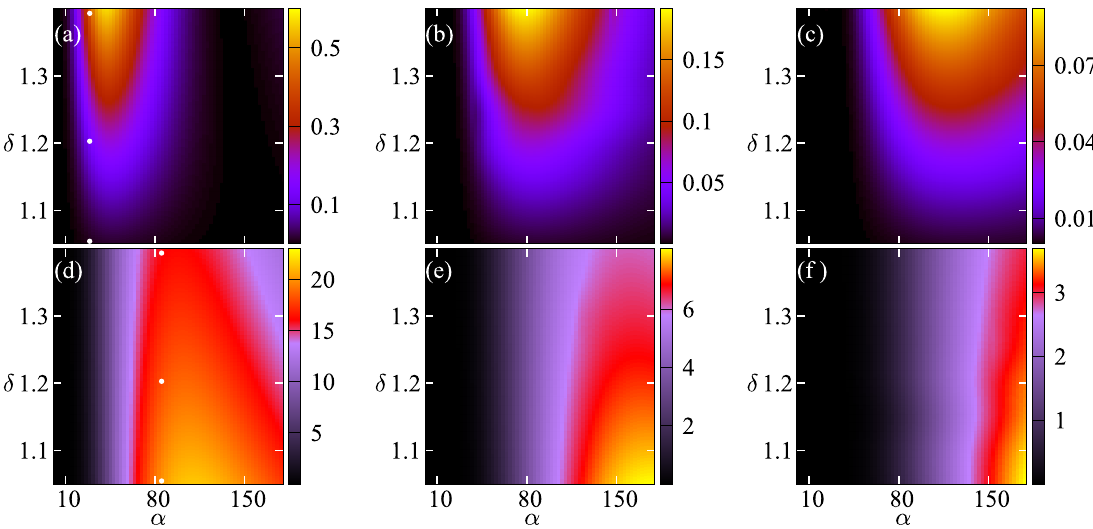
Figure3: Colormapsshowingthedependenceoftheharmonicemission | I ( v ) | 2 ontheparameter α andasymmetrycoef fi cient δ for(a) l =2,(b) l = 4, (c) l = 6, (d) l = 3, (e) l = 5 and (f) l = 7 harmonics. The white dots in panels (a) and (d) correspond to the values of α and δ used in the time domaincalculationsdepictedinFigure6(c)andFigure6(d)respectively.Thecolorbarisnormalizedtothepeakcurrent j 0 .Thecolormapswere calculated using Eqs. (3) – (6).